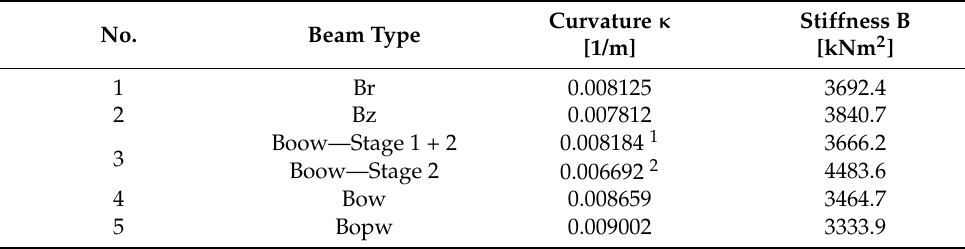
Table 7. Values of curvature and stiffness of CFRP strengthened beams at load of 60 kN (which corresponds to design load-carrying capacity of reference beam) based on experimental results.